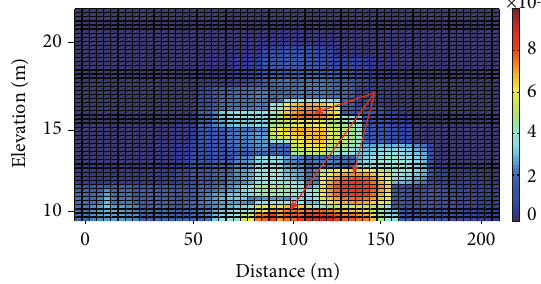
Figure 11: The maximum normal stress distribution on the rigid retaining wall in history